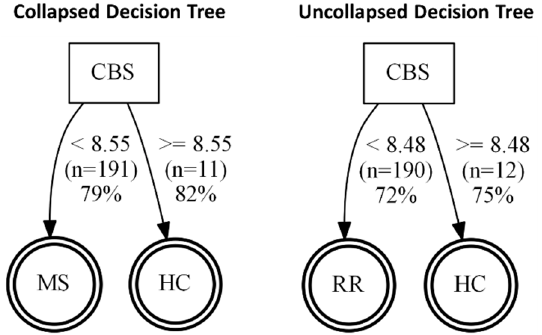
Figure 5. Diagram of decision trees for diagnostic evaluation of MS ( left ) and RRMS ( right ) based on CBS. Left—collapsed evaluation suggests that using CBS as a biomarker, MS can be discriminated from controls with 79 and 82% accuracy. Right—uncollapsed decision tree shows that CBS can also be used to discriminate RRMS from healthy controls with 72 and 75% accuracy, respectively.